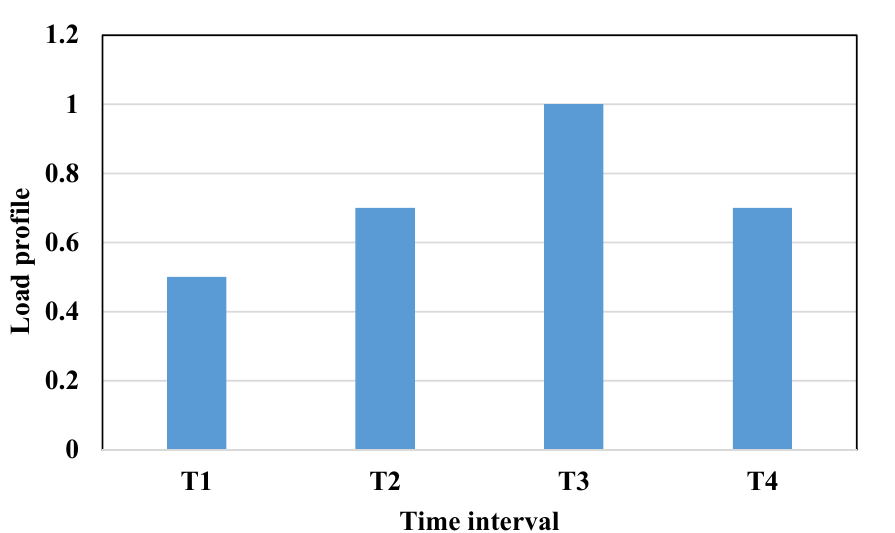
Figure 1. Single-line diagram of the test MG.